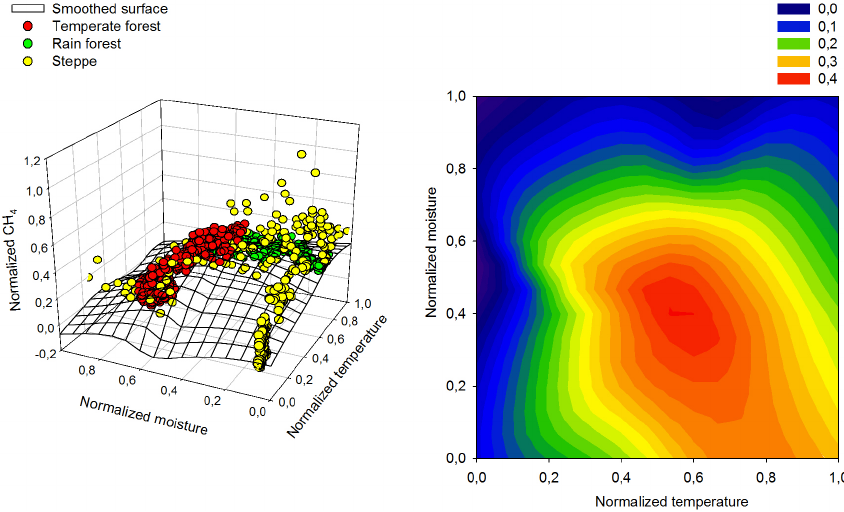
Fig. 11. Temperature and moisture effects on methane uptake fluxes across all three ecosystems (temperate forest, semi-arid steppe, and tropical forest). For this analysis, soil moisture and soil temperature as well as methane uptake flux data were normalized across ecosystems (see Fig. 9). Prior to the calculation of contour lines, data were smoothed with the loess algorithm (sampling proportion = 0.5). Data for temperate forest were randomly selected for the observation years 1995 and